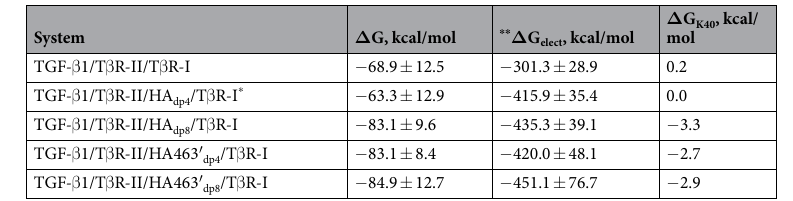
Table 1. MM-PBSA analysis of T β R-I binding to TGF- β 1/T β R-II in the presence and absence of GAGs. * GAG did not behave stable in the MD and dissociated; ** Electrostatic